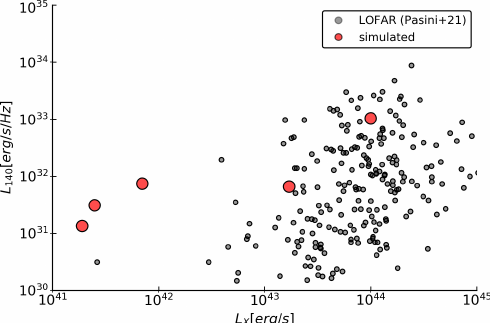
Figure 1. Total radio emission within ≤ 500 kpc from each simulated radio galaxy at 140 MHz, versus the X-ray emission in the [0.5–2] keV range within the same regions in the host cluster. The grey points show the real LOFAR-HBA and eRosita observations from